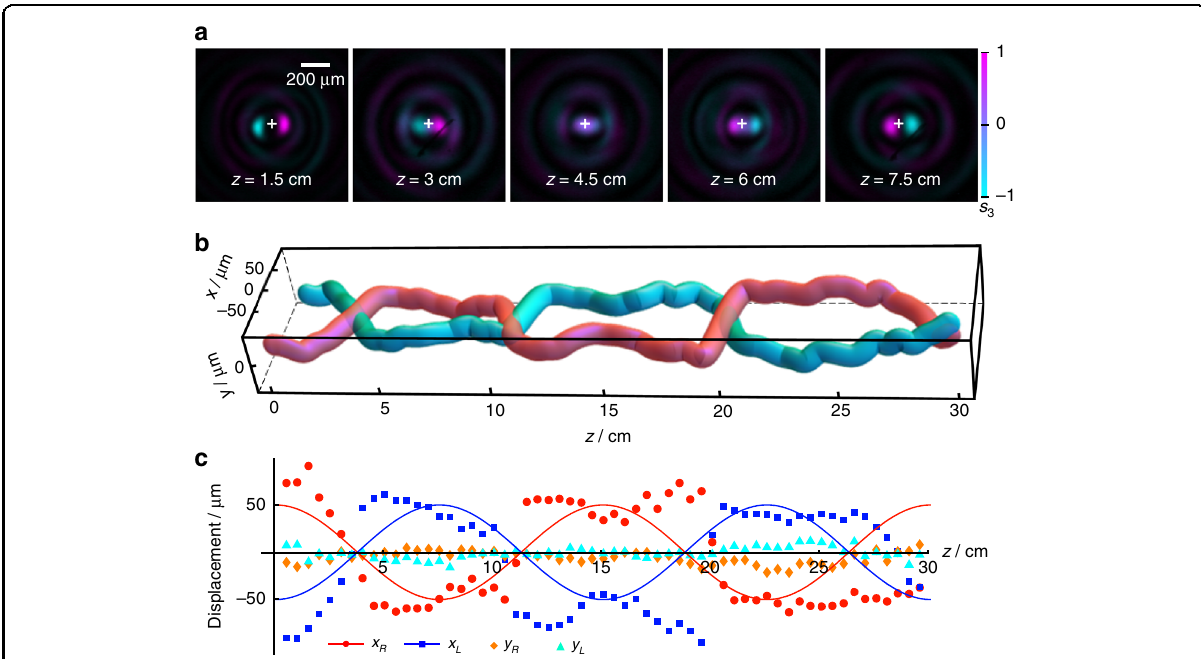
Fig. 5 Cosine-like PSHE of Bessel beam. a Transverse pro fi les of the light fi elds at different distance. b Measured trajectories. c Displacements of the spin states vs. propagation distance, where the solid lines depict the theoretical curves